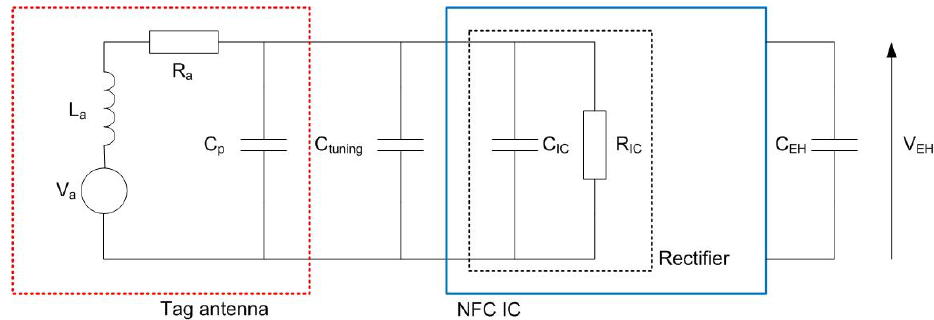
Figure 5. Equivalent circuit of the tag antenna and NFC